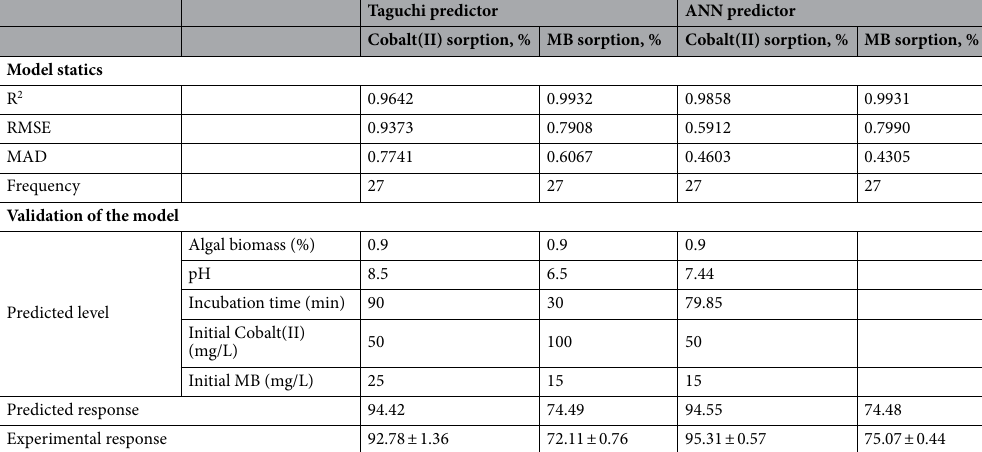
Table 4. Statistics of and performance of Taguchi and ANN models for Cobalt(II) and MB biosorption by the biomass of Sargassum latifolium . RMSE is the root mean squared error, and MAD is the mean absolute